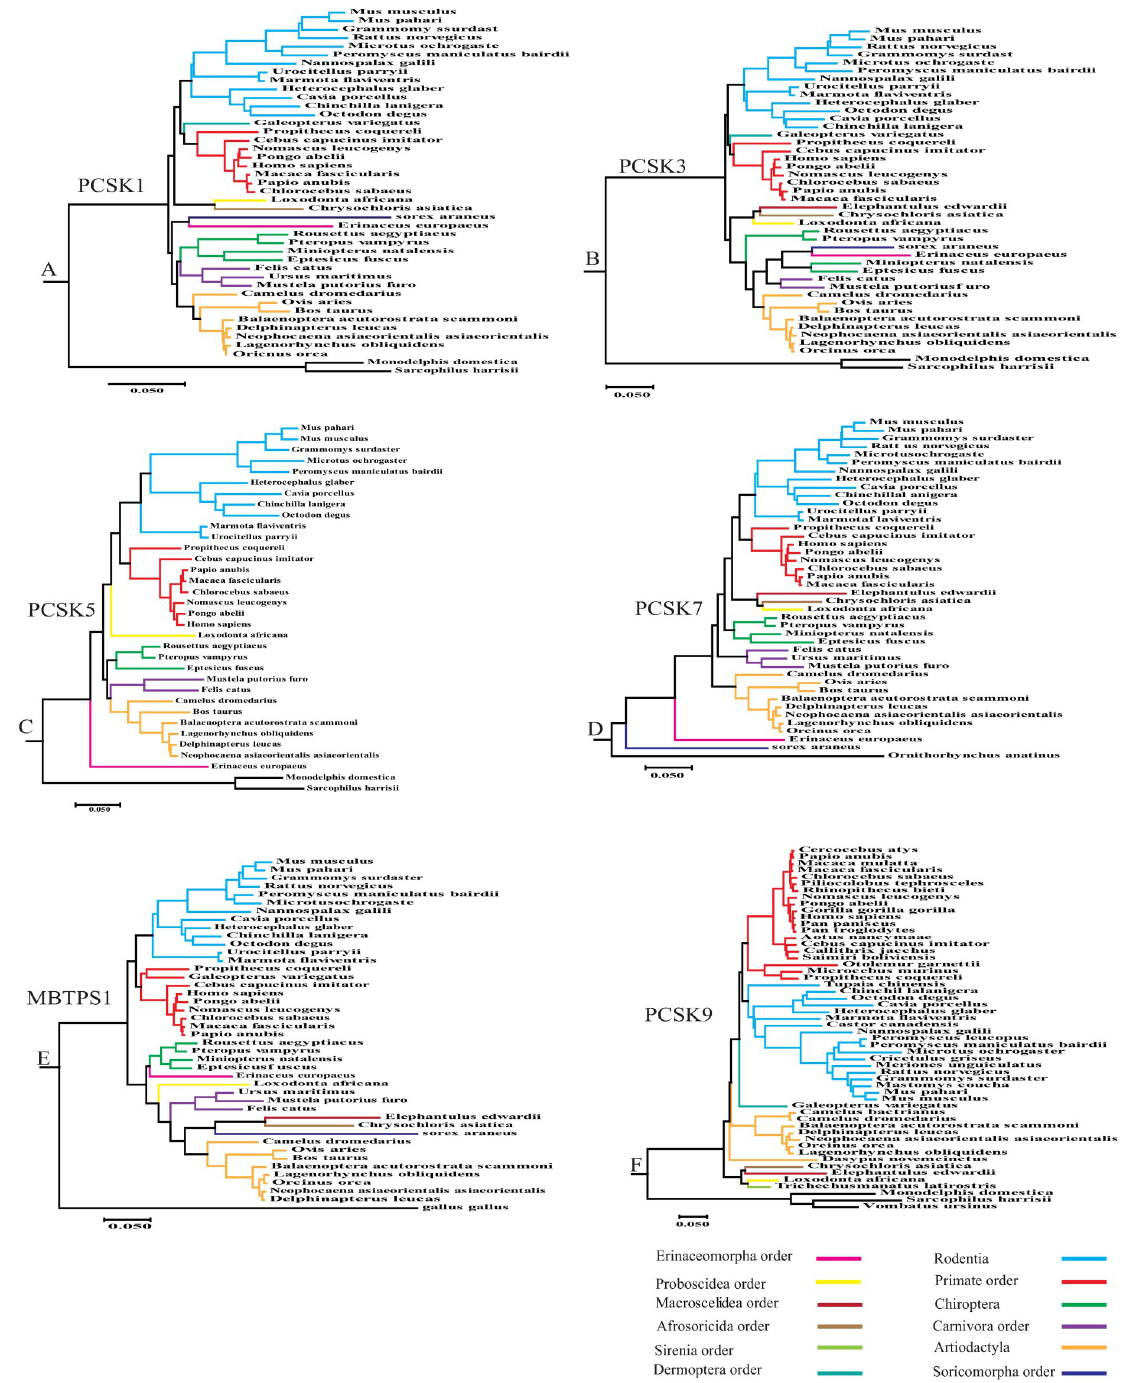
Fig 5. PCSKs Phylogenetic trees. Phylogenetic trees constructed by Maximum Likelihood method analysis of the coding sequences of PCSKS (bootstrap 1000) in mammalian species belonging to major placental mammalian orders. Orders are indicated by different colors. Branch length scale represents number of 0.05 substitutions per